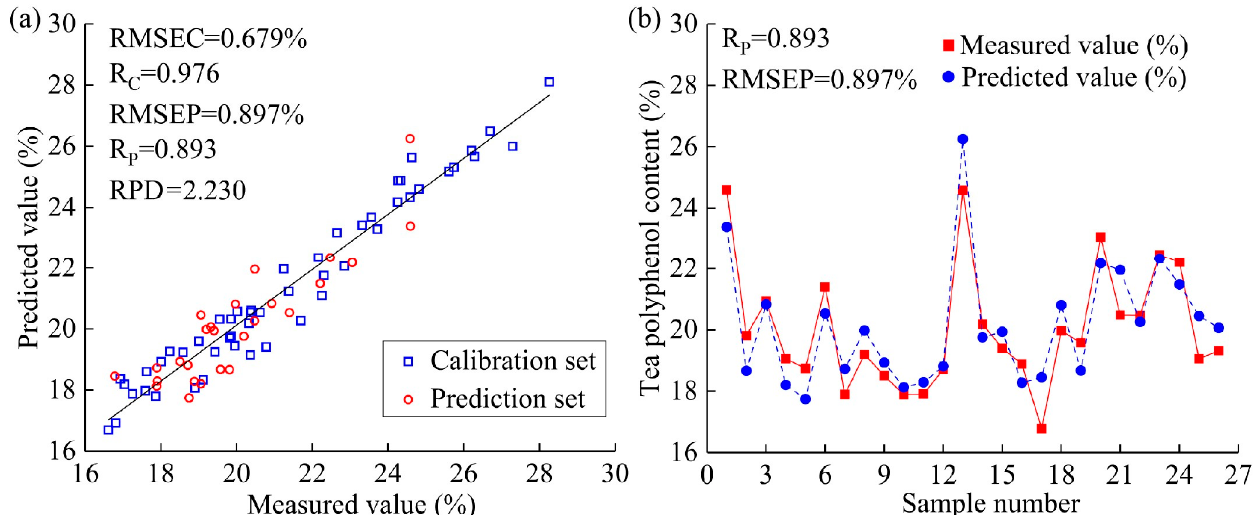
Figure 7. LS–SVR modeling performances of predicting tea polyphenol content based on dual-band spectral data. ( a ) Correlation analysis of a scatter plot. The hollow square and circle markers denote the calibration set and prediction set, respectively. The black line is the regression for the whole set. ( b ) Comparison of predicted and measured values of tea polyphenol content. The solid square and circle markers represent the measured value and predicted value, respectively.